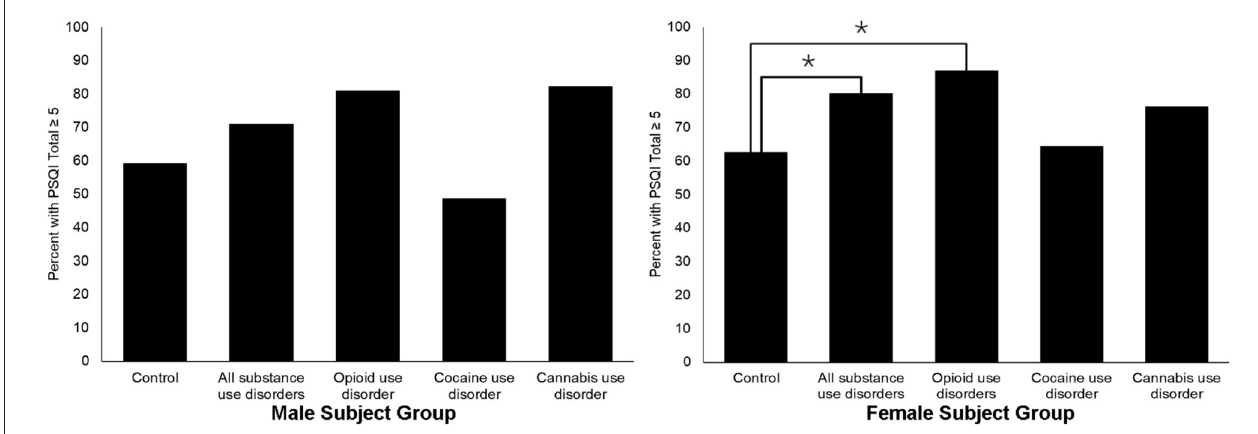
FIGURE 1 | Sex-specific prevalence of PSQI score ≥ 5 for SUD and control study subjects. The *symbol indicates the differences between groups significant at p <